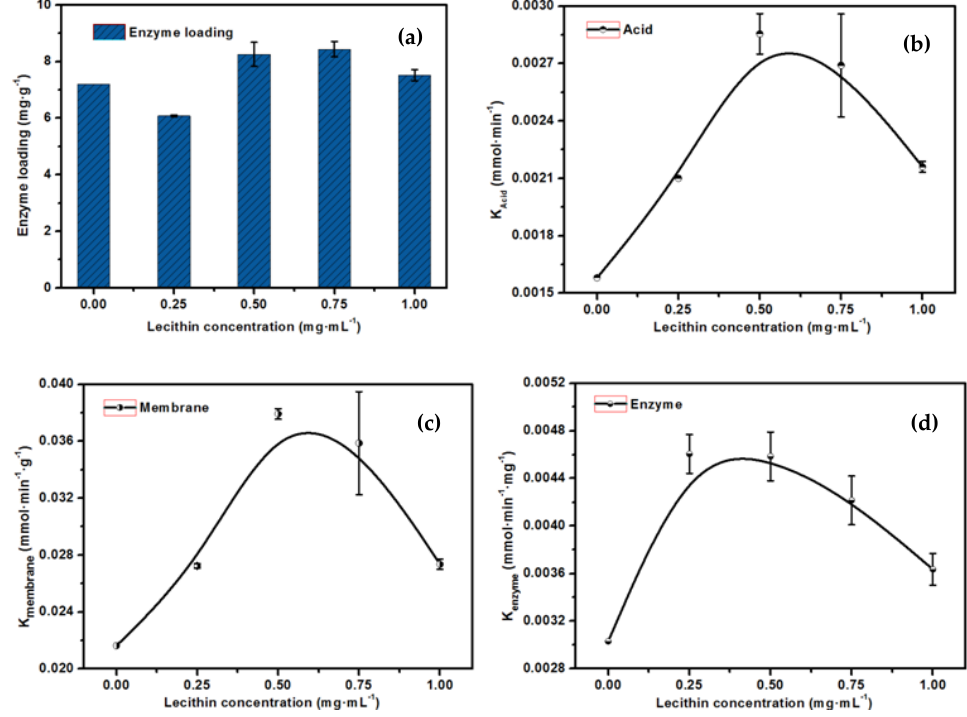
Molecules 2018 , 23 , 144 Figure 6. The effect of the concentration of the lecithin on the performance of the EMBR ( a – d ).